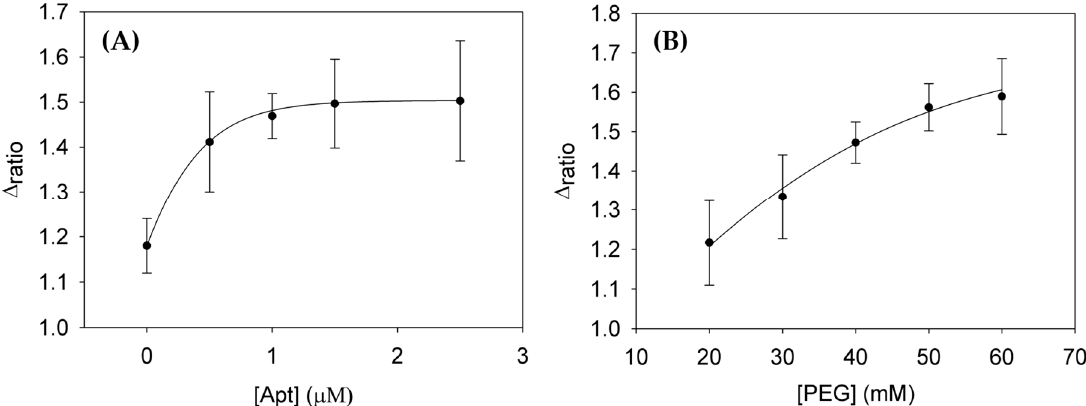
Figure 5. ( A ) Optimization of the concentration of AptLys; ( B ) Optimization of the concentration of the blocking agent, PEG. Uncertainly values corresponding to replicated experiments ( n = 5).